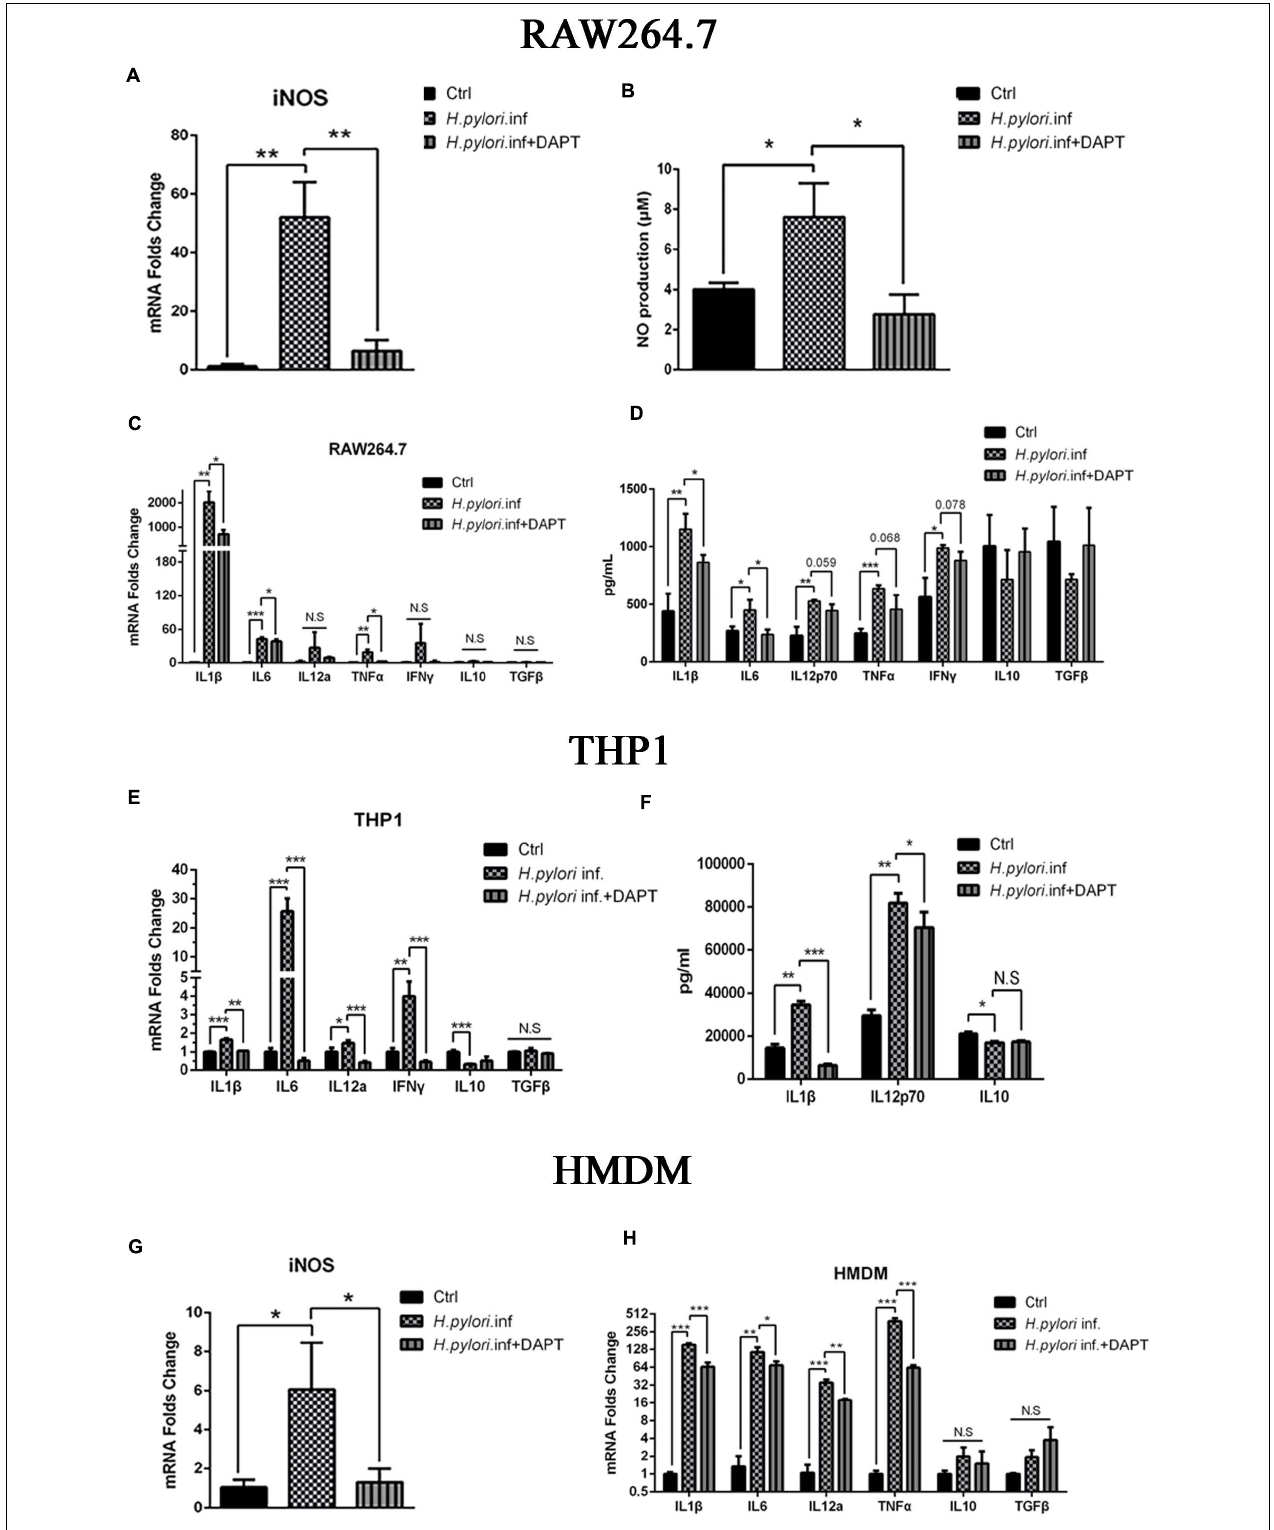
FIGURE 1 | Inhibition of Notch decreases the expression of pro-inflammatory mediators in macrophages during Helicobacter pylori (H. pylori ) infection. Macrophages were pretreated with DAPT for 12 h and then co-cultured with H. pylori (MOI = 50) for 12 h. DMSO (0.08%) was used as control for DAPT. PBS